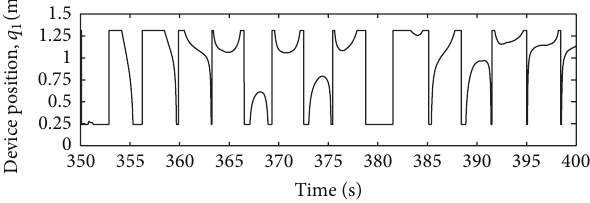
Figure 14: Time history of device position ( 0 % stiffness